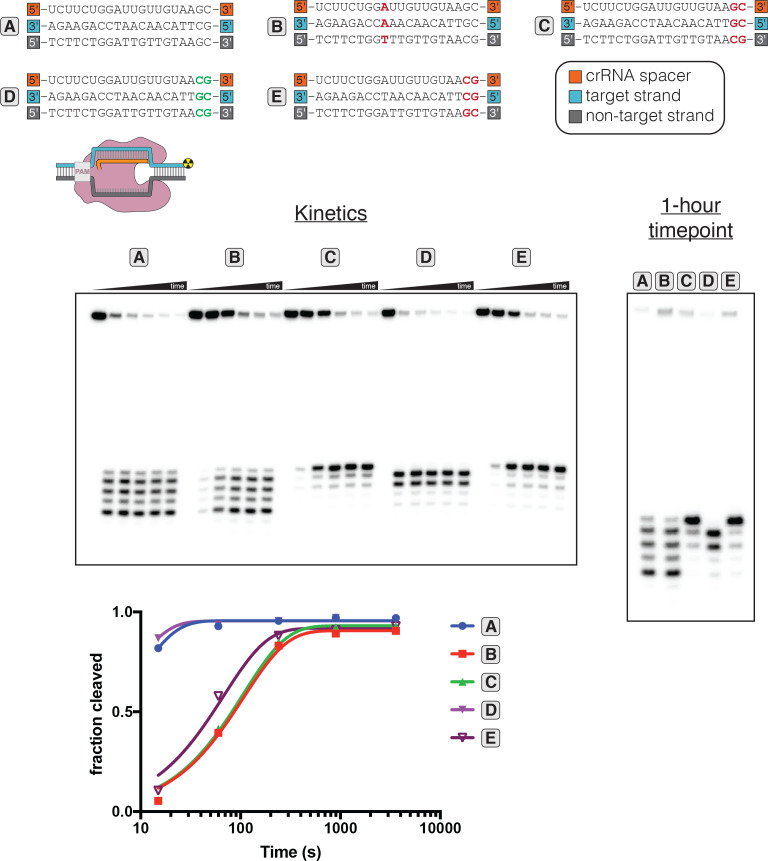
Determinants of altered target-strand cleavage kinetics and position.100 nM AsCas12a and 120 nM crRNA were incubated with 1 nM duplex DNA target radiolabeled on the 5' end of the target strand at 37°C for 0 s, 15 s, 1 min, 4 min, 15 min, or 1 hr, prior to quenching and resolution by denaturing PAGE. The 20-nt target sequence immediately adjacent to the PAM is shown below the crRNA spacer sequence used in each experiment. Red letters indicate TS:crRNA mismatches. Green letters indicate compensatory changes in the crRNA to restore a 20-nt match. The final timepoint of each reaction is reproduced in the gel on the right, for side-by-side comparison of the cleavage site distributions. ‘Fraction cleaved’ is defined as (sum of the volume of all bands below the uncleaved band)/(total volume in lane). Data were fit to an exponential decay (y = (y0-plateau)*exp(-k*x)+plateau), with y0 constrained to 0 and the plateau value constrained to ≤1. A representative replicate is shown. The value of kobs for each time course is as follows: A (0.12 s−1), B (0.0093 s−1), C (0.0094 s−1), D (0.16 s−1), E (0.015 s−1). The precise value of kobs for A and D should be interpreted with caution due to poor sampling of informative timepoints.